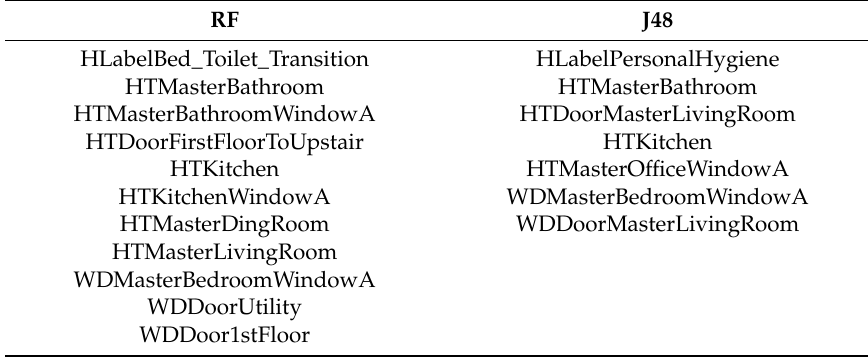
Table 7. Selected SH attributes that as a group predict outdoor PM 2.5 in IAQ 1